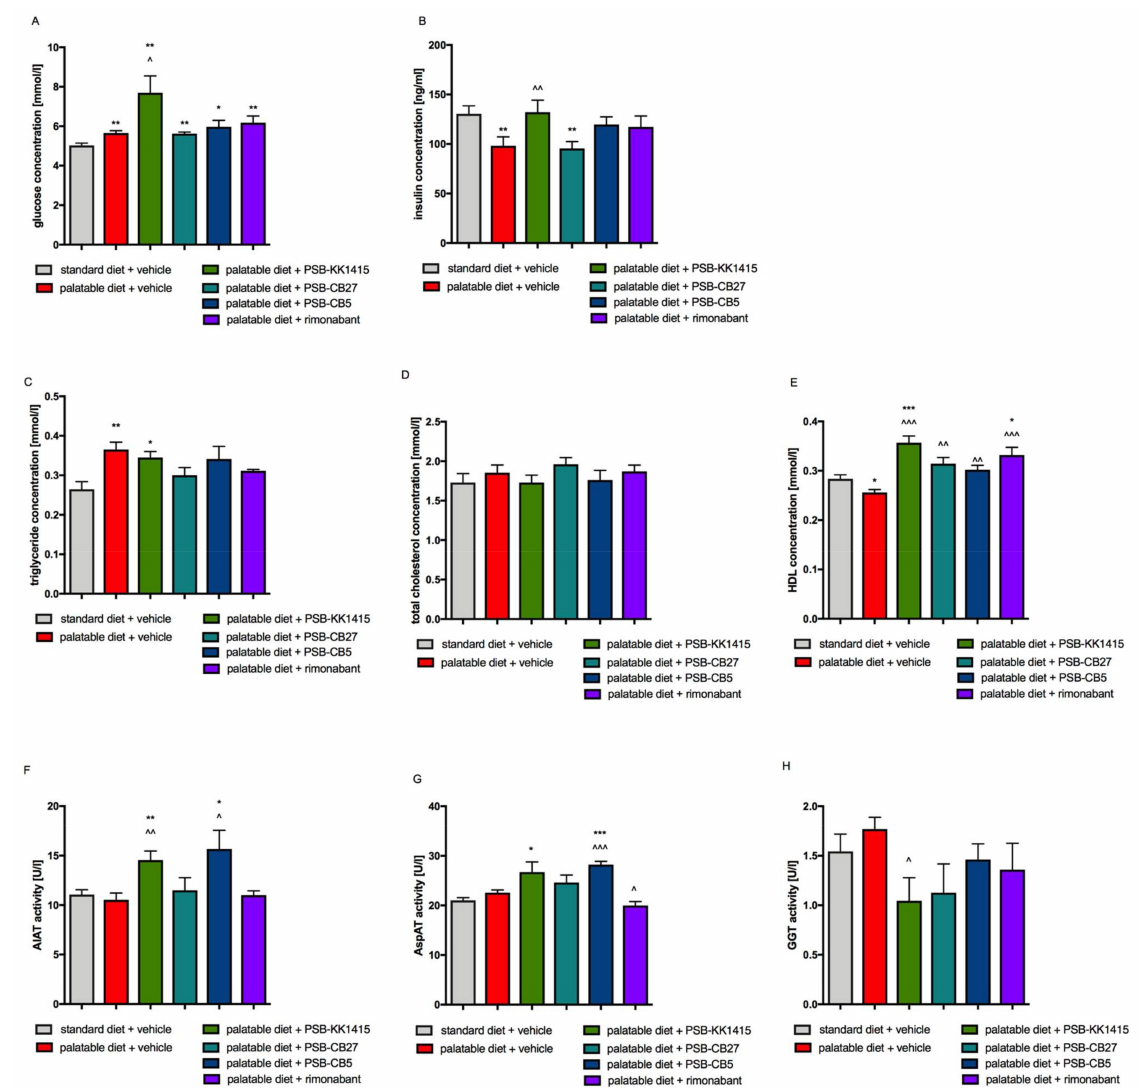
Figure 4. Effect of administration of the GPR18 ligands or rimonabant on plasma glucose ( A ), insulin ( B ), triglyceride ( C ), total cholesterol ( D ) or HDL-cholesterol ( E ) level or alanine aminotransferase ( F ), aspartate aminotransferase ( G ), γ -glutamyl transpeptidase, and ( H ) activity of female Wistar rats fed a palatable feed. Results are the means ± SEM, n = 6. Multiple comparisons against the vehicle-treated control group (*) or against the vehicle-treated obese control group (ˆ) were performed by one-way ANOVA Tukey post hoc; Significant differences are denoted by *,ˆ p < 0.05, **,ˆˆ p < 0.01, ***,ˆˆˆ p <